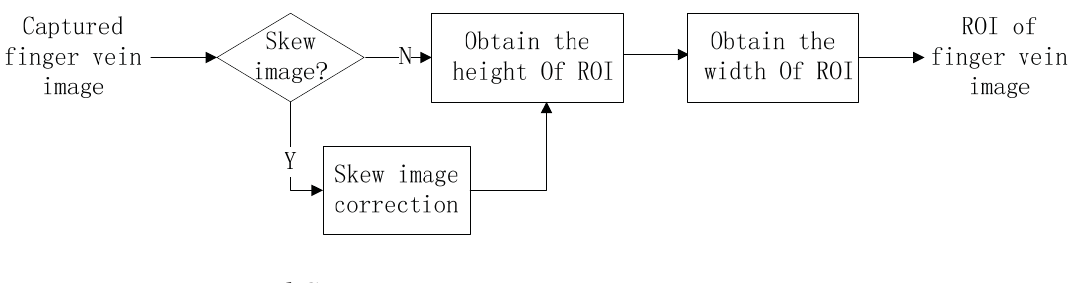
Figure 1. The block diagram of primary steps employed in ROI